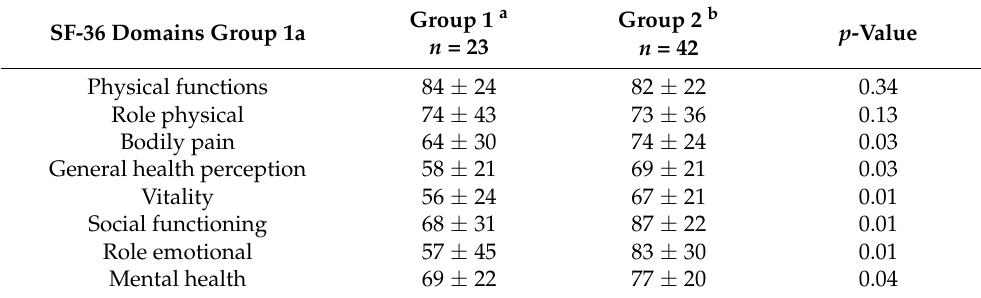
Table 2. Mean ( ± standard deviation) values of the SF-36 domains according to genotypic groups of the patients.